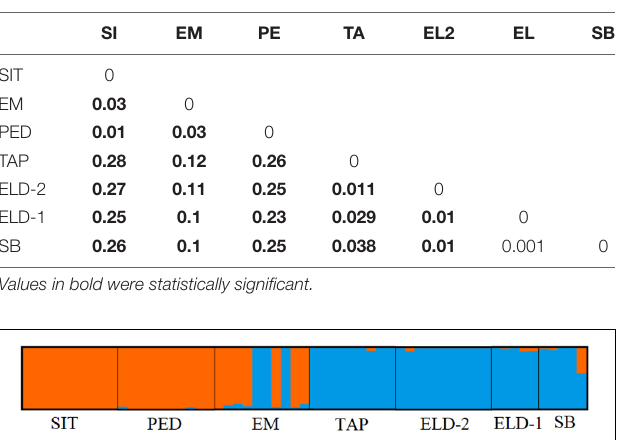
FIGURE 3 | STRUCTURE software result showing the two genetic clusters inferred by the Evanno